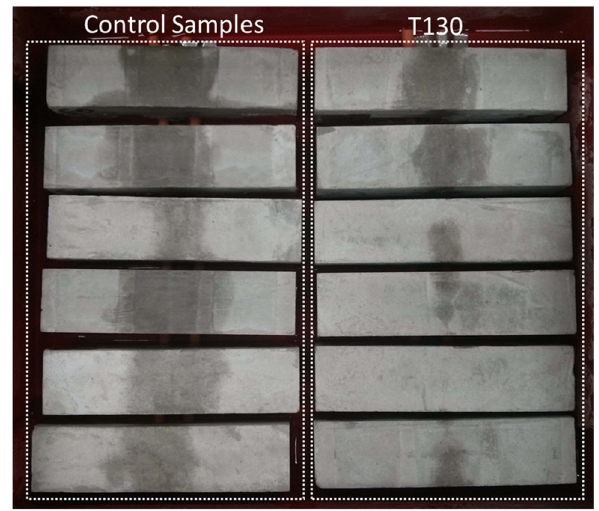
Figure 13: Sorptivity measurements are taken over a 28 - day healing period. Comparison of later absorbed by cement ( left ) control cement paste samples and ( right ) cement paste samples containing 4% T130 microcapsules ( polyurea microcapsules ) . Testing is after a s7 - day healing period [ 94 ] .